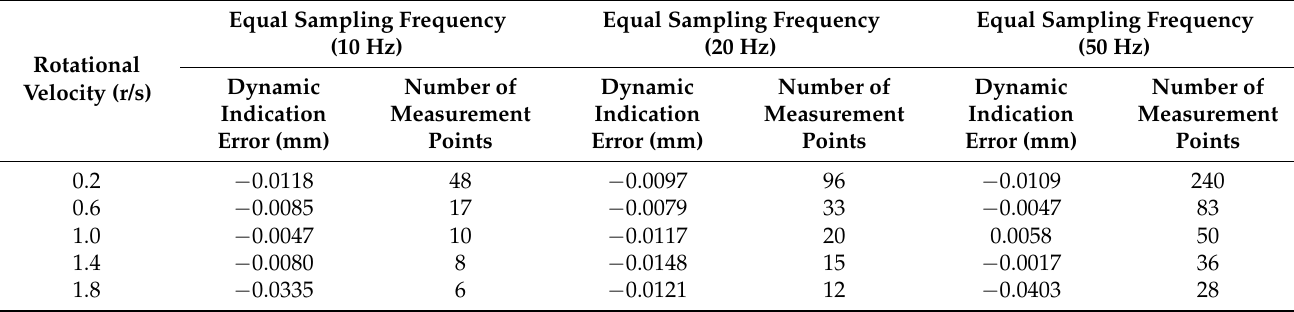
Table 3. Dynamic performance of laser tracker at equal sampling frequency and different speeds (D = 3